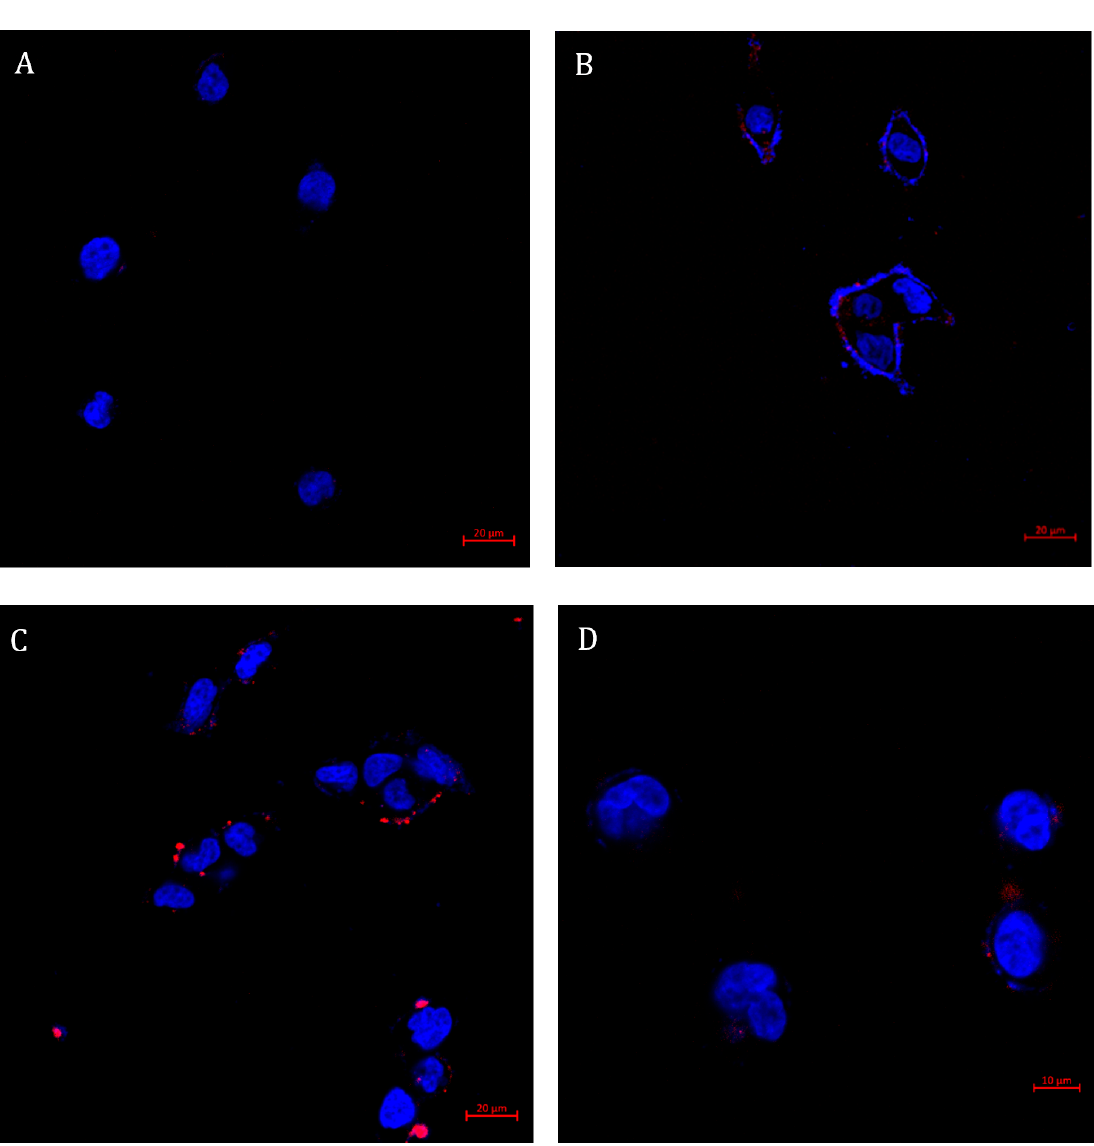
Figure 9. Selective targeting of NPs decorated with increasing concentrations of the TL, to PSMA- overexpressing LNCaP cells. Confocal laser microscopy images of LNCaP cells, following 2 h incubation with: ( A ) NPs lacking TL decoration; ( B ) NPs decorated with 15 nM of TL; ( C ) with 30 nM of TL; and ( D ) with 80 nM of TL (at 37 ◦ C; samples were diluted 1:400 ( v / v ) in FBS-free medium). Nuclear DNA staining was achieved with Hoechst 33342 (1 µ g/mL) and is marked in blue, whereas NPs labeled with Cy7 are marked in red. Scale bars denote 20 µ m in ( A – C ), and 10 µ m in ( D ). To verify the specific internalization of targeted NPs to LNCaP target cells via the PSMA receptor, different cell lines were examined including PC-3, NSCLC 1975, HEK- 293, BEAS2B, and FSE cell lines (Figure 10). were those decorated with 30 nM